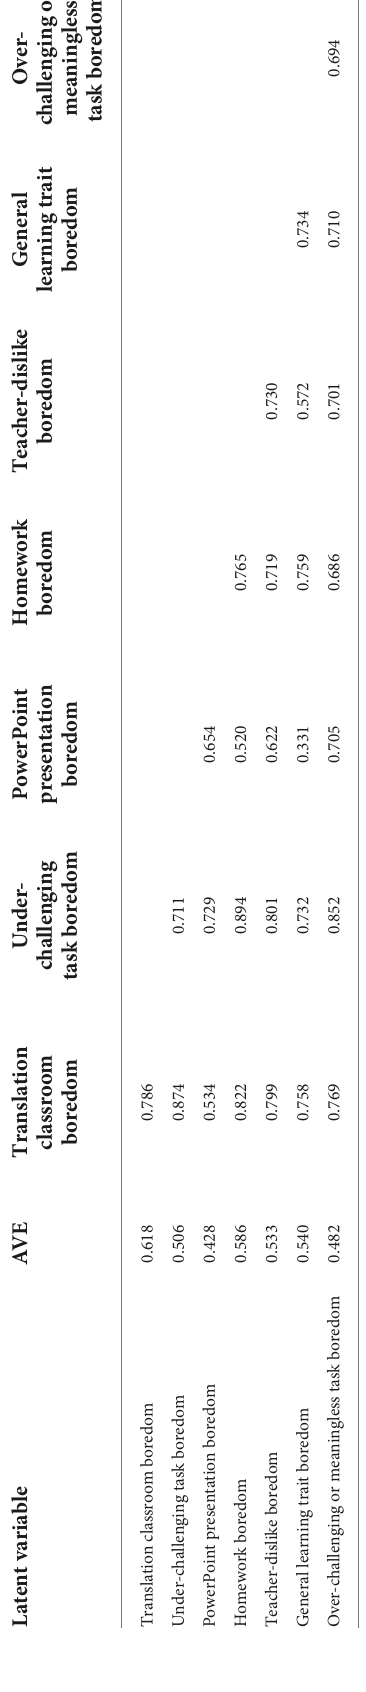
TABLE 4 Results of goodness-of-fit indices of the